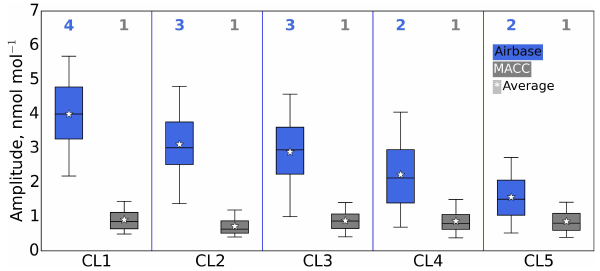
Figure 16. Percentiles (5–25–50–75–95) of ozone seasonal ampli- tudes in clusters; Airbase vs. MACC, second CA. Upper values in- dicate the mean seasonal amplitude of each